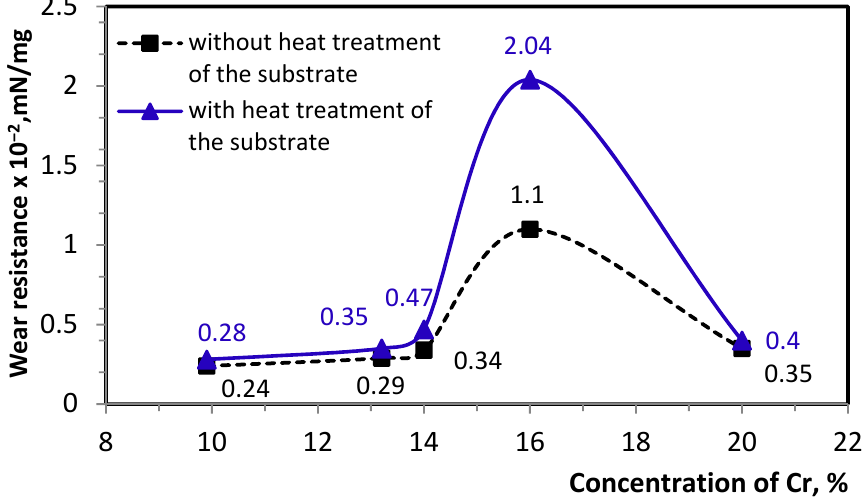
Figure 9. Dependence of wear resistance on the concentration of chromium in the tested HVOF coatings.